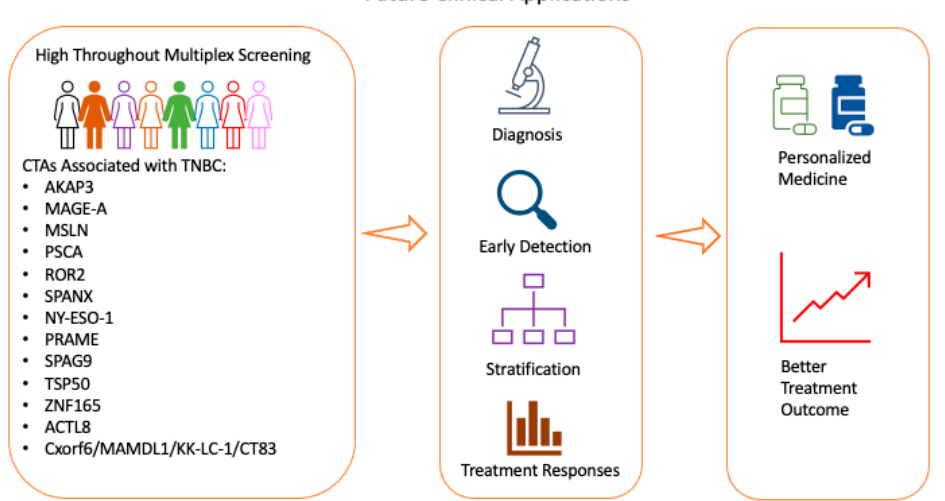
Figure 2. Potential workflow in screening for CTAs in TNBC. The expression of CTAs in TNBC provides great promise for enhancing current screening, diagnosis and treatment methods. TNBC: triple-negative breast cancer; CTA: cancer-testis antigens.